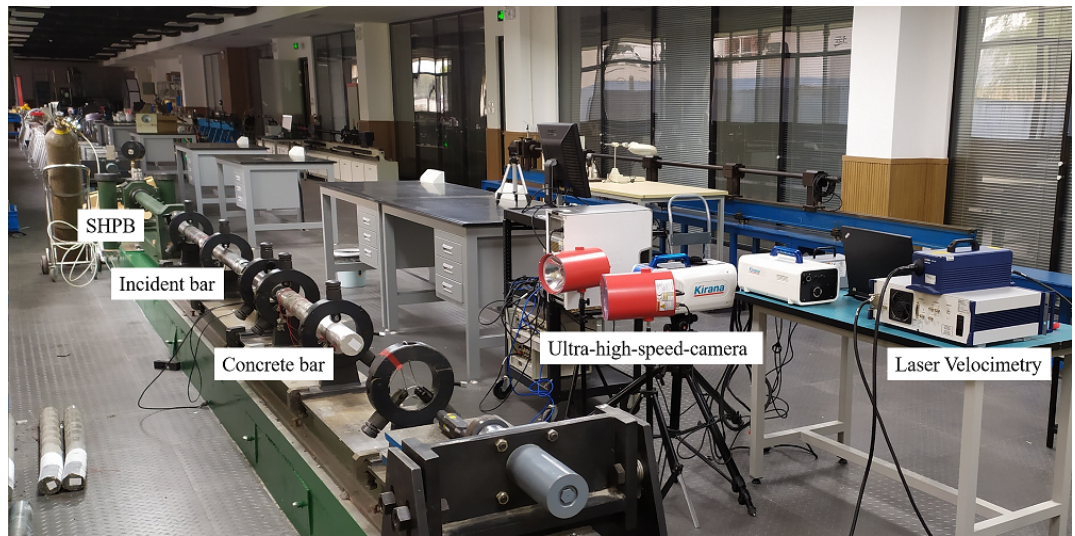
Figure 5. Experiment setups for the spalling tests including the SHPB, the concrete bar, the ultra-high-speed camera, the laser velocimetry, and the data acquisition